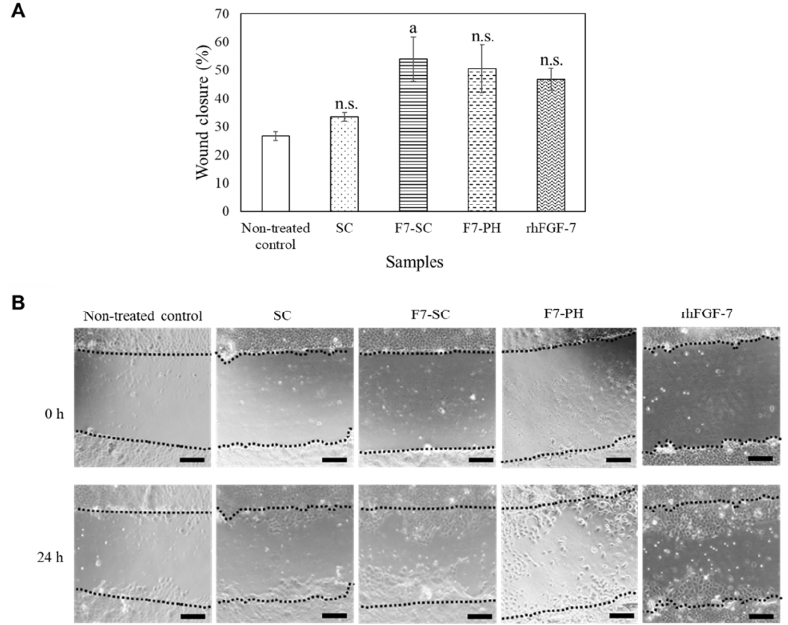
Figure 5. Migration of NHEK cells induced by H1/FGF-7. NHEK cells at a density of 7500 cells per 500 µL of DK-SFM were incubated at 37 °C and 5% CO 2 for 16 h to induce starvation and then wounded via scratching. The wounded cultures were treated with 100 µg of SC powder, 100 µg of F7-SC powder, 5 × 10 5 F7-PH, or 10 ng of rhFGF-7, or PBS was added (for non-treated control); then, they were further incubated for 24 h. ( A ) The percentage of wound closure in the scratched NHEK cultures was determined through ImageJ analysis of the photos taken at 0 and at 24 h of treatment. Data are shown as means ± standard deviations (SDs) of triplicate assays. n.s p > 0.05 vs. non-treated control and a p < 0.05 vs. non-treated control. ( B ) Photos of the scratched cultures for ImageJ analysis. Scale bar, 200 µm.